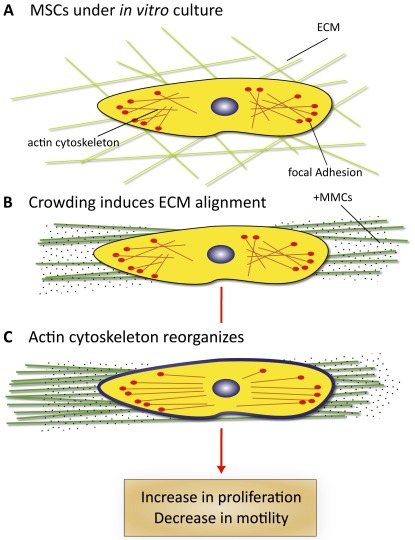
Schematic of cell and matrix reciprocity under macromolecular crowding.(A) Adherent mesenchymal stromal cell (MSC) under typical in vitro culture conditions. (B) Upon the addition of macromolecular crowders, excluded volume effects promote bundling and alignment of extracellular matrix (ECM) fibers. (C) In response to the aligned ECM, the intracellular actin cytoskeleton reorganizes to align with the ECM. In addition, the cell secretes more matrix proteins, which are deposited to and further enhance the alignment of the ECM. We find that these reciprocal changes in the matrix material and intracellular cytoskeletal organization correlate with an increase in proliferation and a decrease in motility of MSCs.